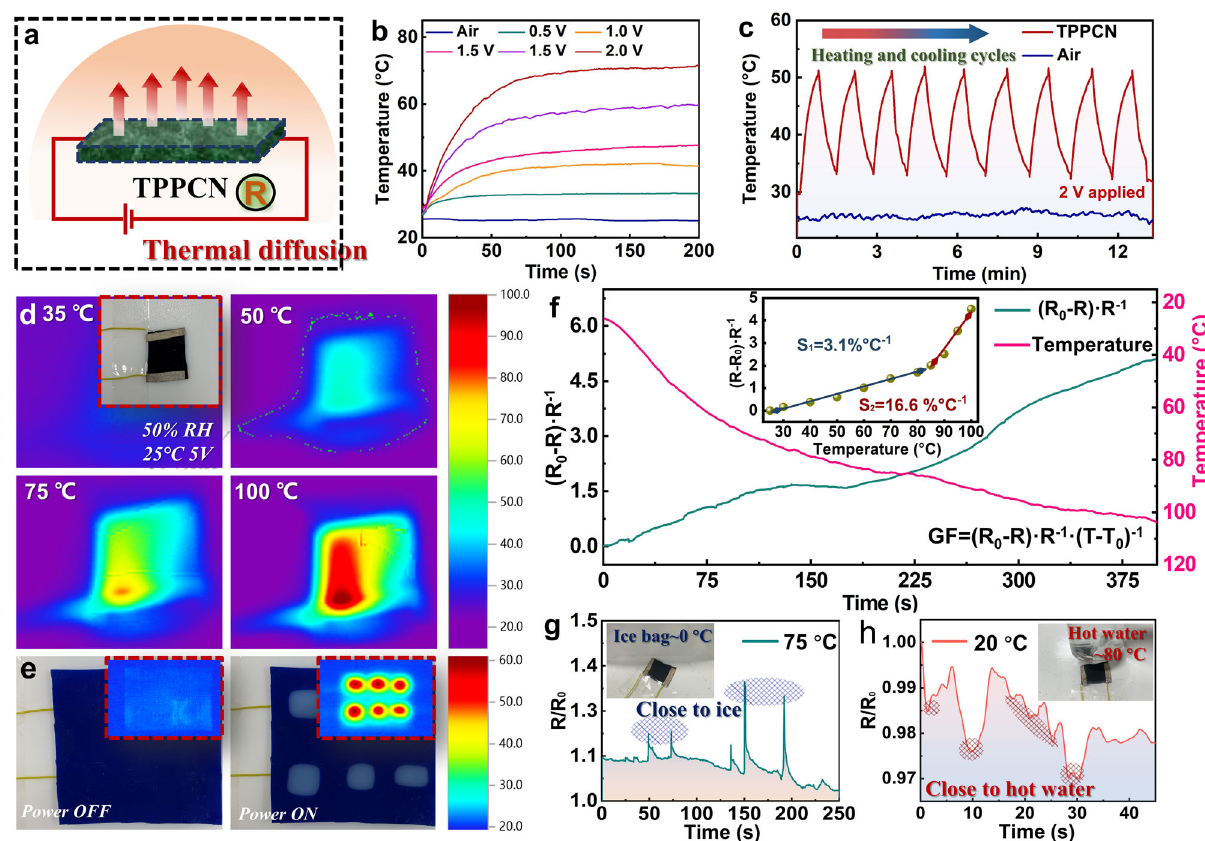
Fig. 6 Electric- thermal performance of TPPCN membrane. a Wearable TPPCN membrane as a thermal heater. b Temperature curves of the TPPCN membrane under the electric fi eld of different voltage. c Repeatable behavior when heating the TPPCN membrane. d IR images of TPPCN membrane upon applying input voltages of about 5 V. e Demonstration of thermochromism of membrane materials used as a warning device. f Relative resistance change of obtained TPPCN membrane with the increased temperature. g, h Resistance responds upon the variation in